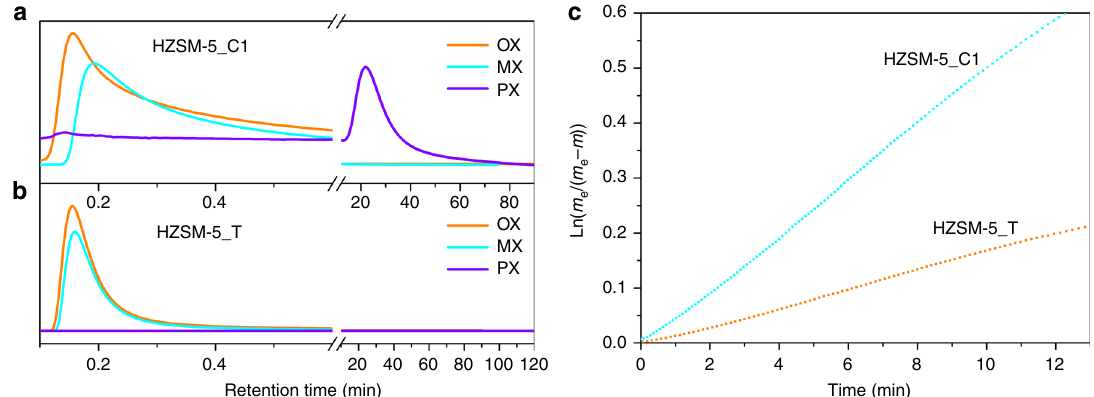
Fig. 4 Comparisons of xylene isomers adsorptions over different zeolite catalysts. Pulse chromatography of xylene isomers (OX: o -xylene; MX: m -xylene; PX: p -xylene) passing through columns packed with cof fi n-shape HZSM-5_C1 ( a ) and b twinned HZSM-5_T, at 220°C. Peak tailing and residence time difference between m -xylene and o -xylene was observed due to the existence of more straight channels openings and easier entry of m -xylene and o - xylene into the straight channels of cof fi n-shape HZSM-5 when compared to twinned HZSM-5. c Room temperature m- xylene adsorption rate over cof fi n- shape HZSM-5_C1 and twinned HZSM-5_T showing a lower m -xylene adsorption rate when less straight channels were involved in the adsorption